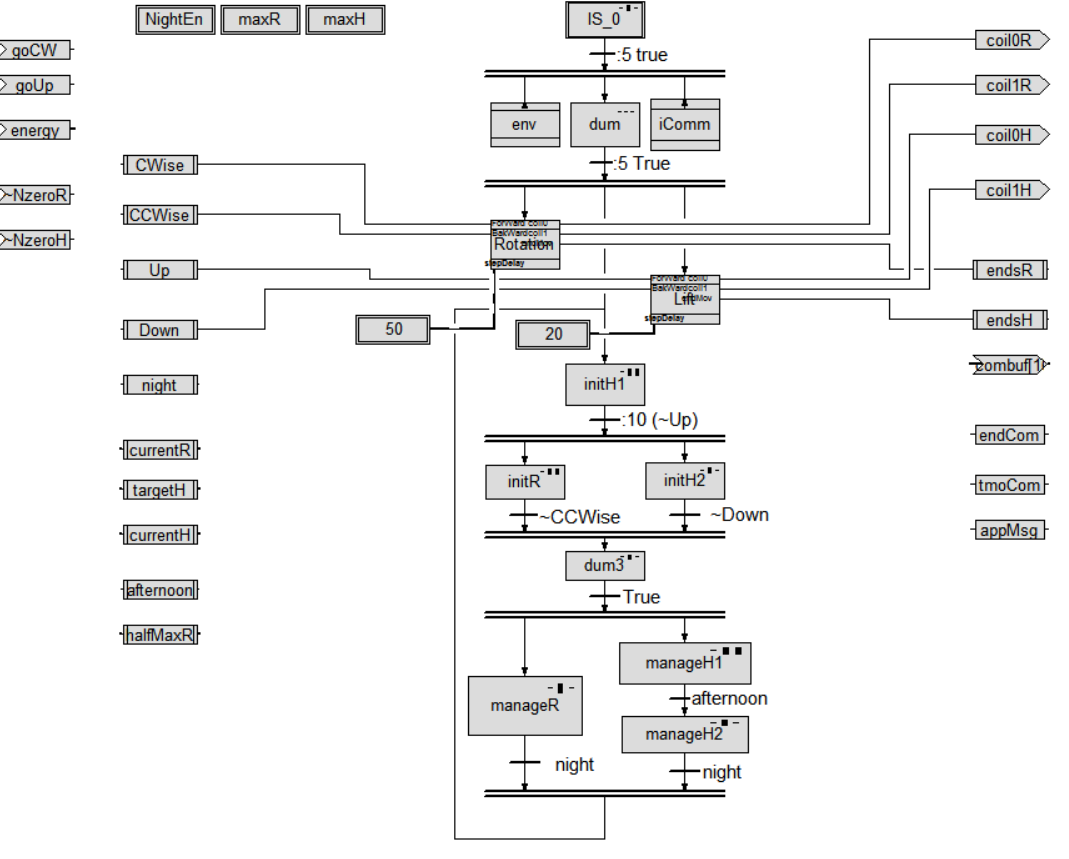
Figure 4. An example of Control Flow.